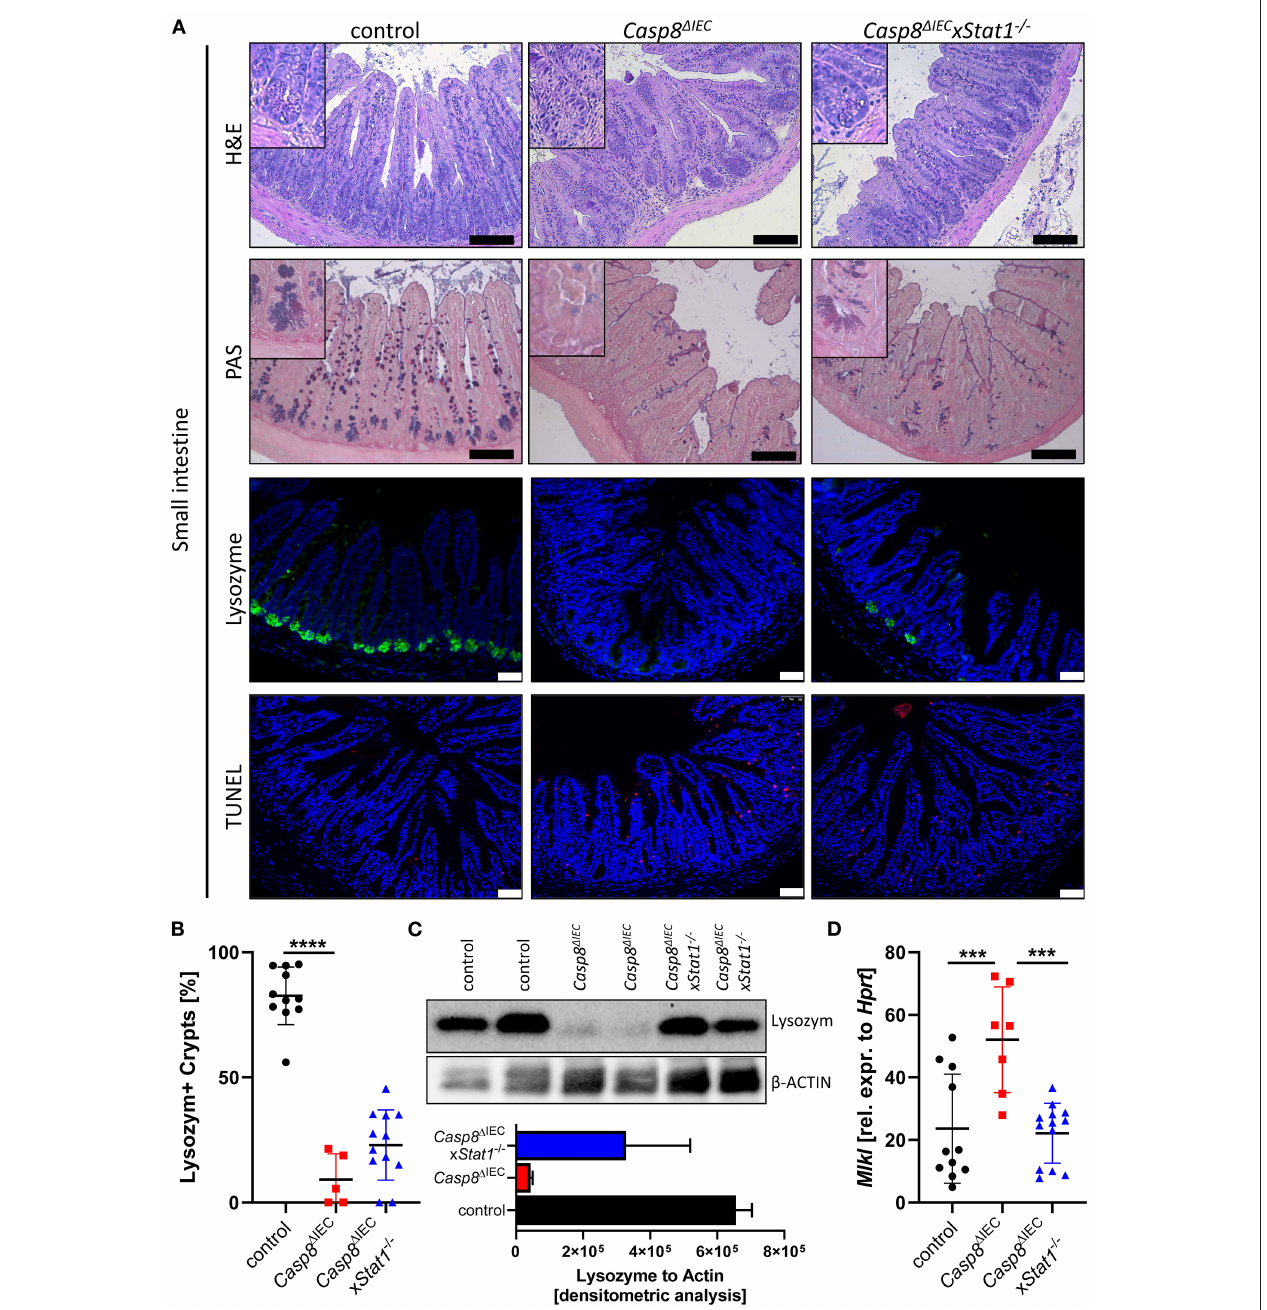
FIGURE 1 | STAT1 signaling attenuates necroptosis and partially restores Paneth cell depletion. (A) Representative images of small intestinal tissue cross sections of wild type control, Casp8 1 IEC , and Casp8 1 IEC xStat1 − / − mice stained with standard H&E, PAS (scale bar: 100 µ m) or immunohistochemically stained (scale bar: 50 µ m) with antibody against Lysozyme (green) or stained with TUNEL assay (red). Nuclei were counterstained with Hoechst 33,342 (blue). (B) Quantification of Lysozyme positive crypts. (C) Western blot analysis Lysozyme in murine ileal tissue. β -Actin was used as loading control. Densitometry analysis for quantification ( n